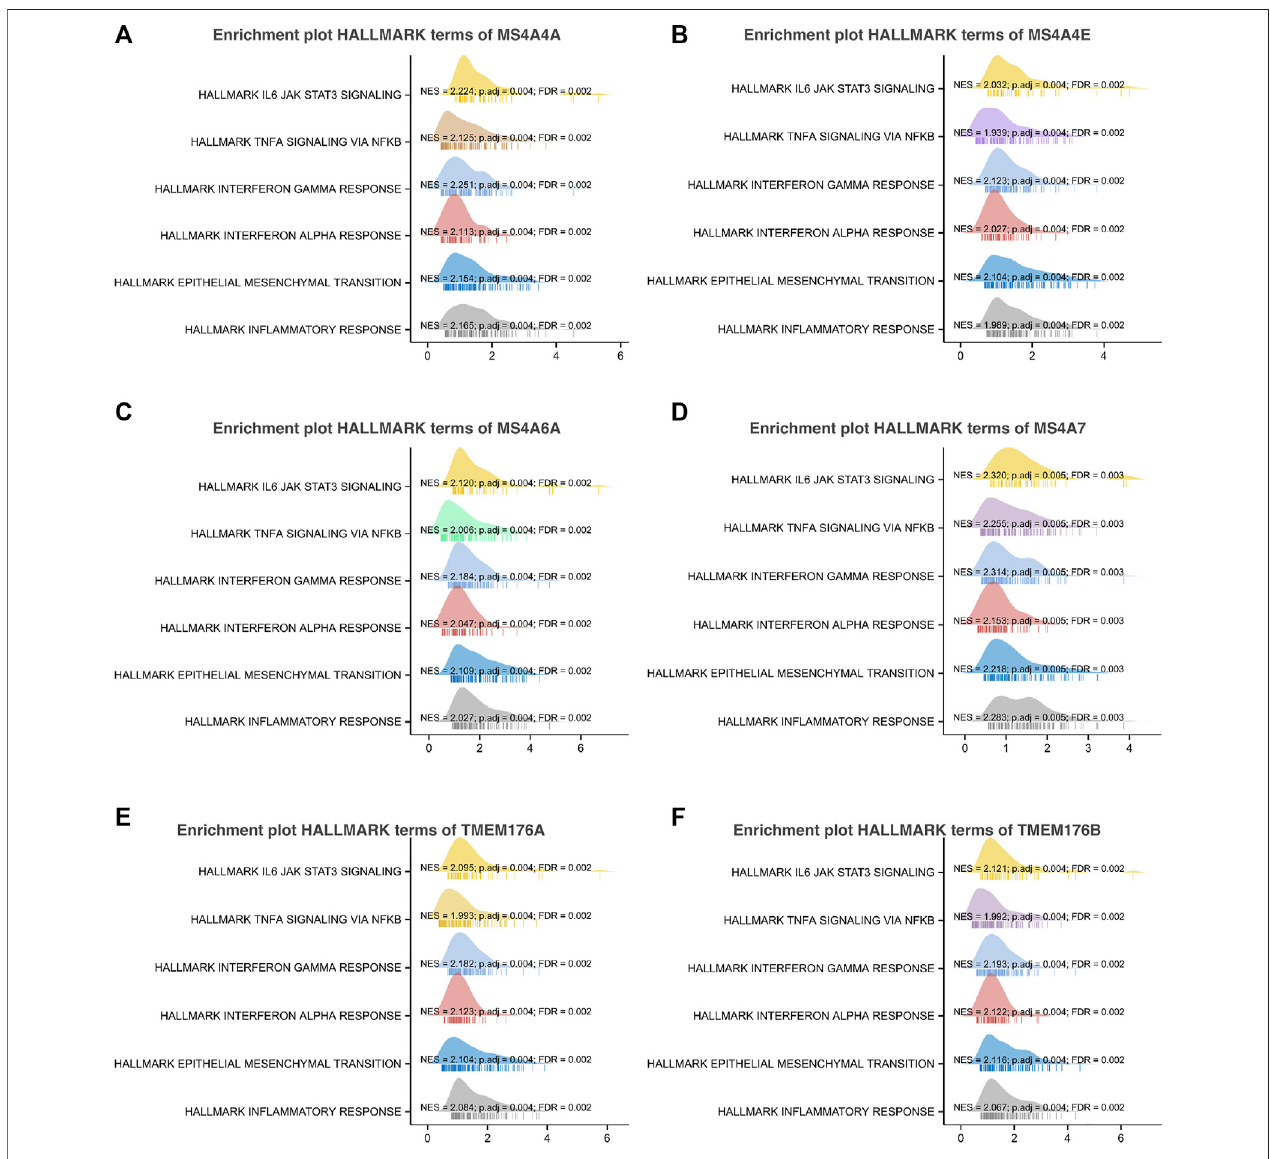
FIGURE 7 | Gene set enrichment analysis of associated genes with MS4As [ (A) MS4A4A; (B) MS4A4E; (C) MS4A6A; (D) MS4A7; (E) TMEM176A; and (F) TMEM176B].